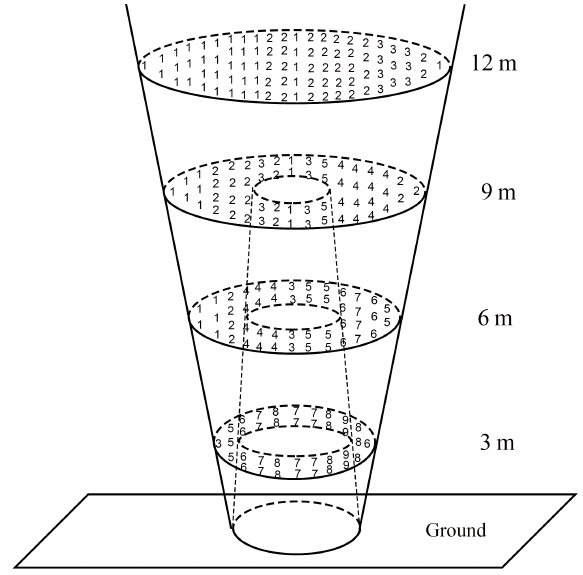
Figure 7. A 3-D structure of the DD’s